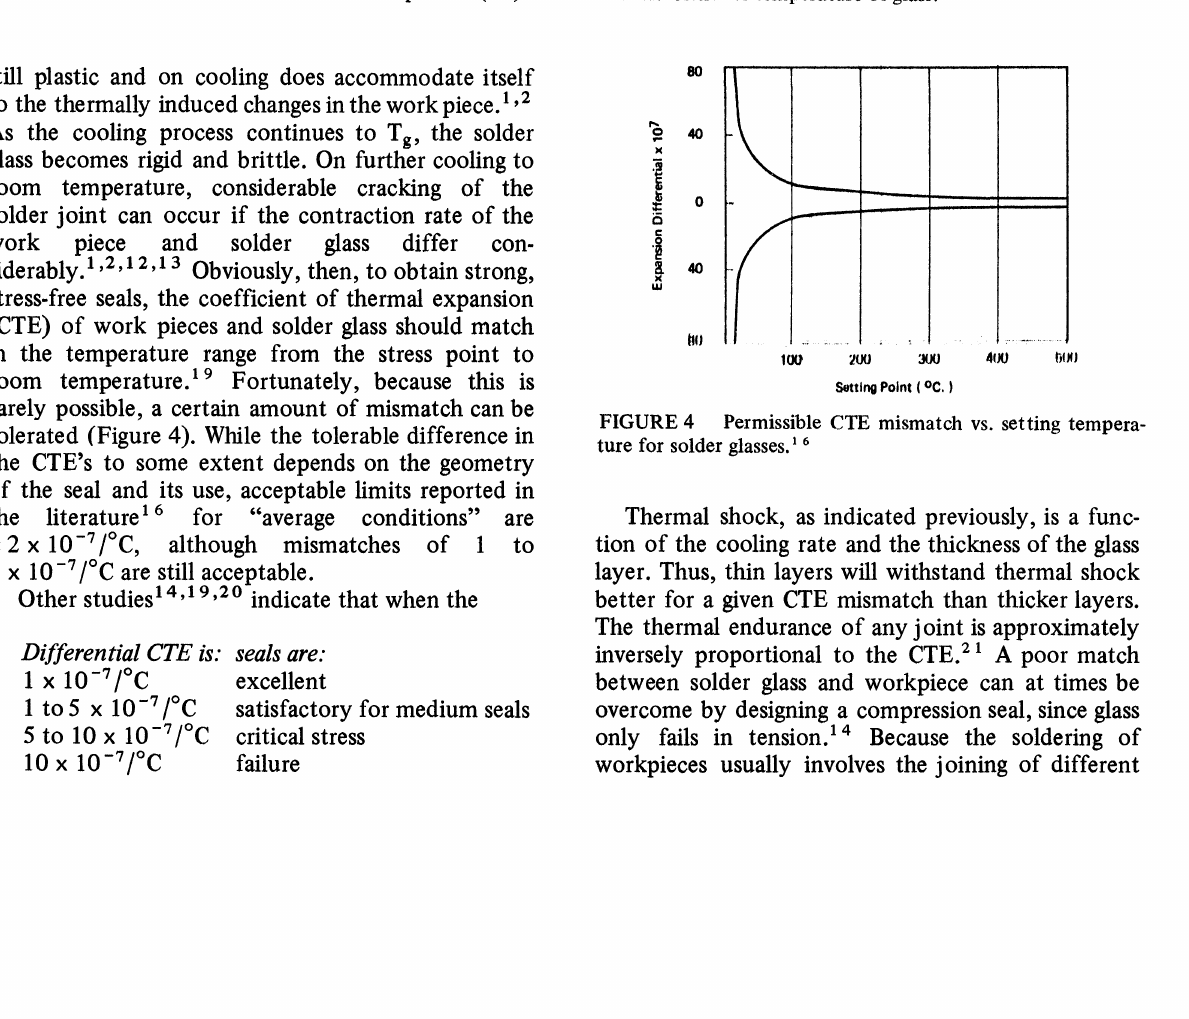
Thermal expansion (TE) and relevant viscosities vs temperature of glass.